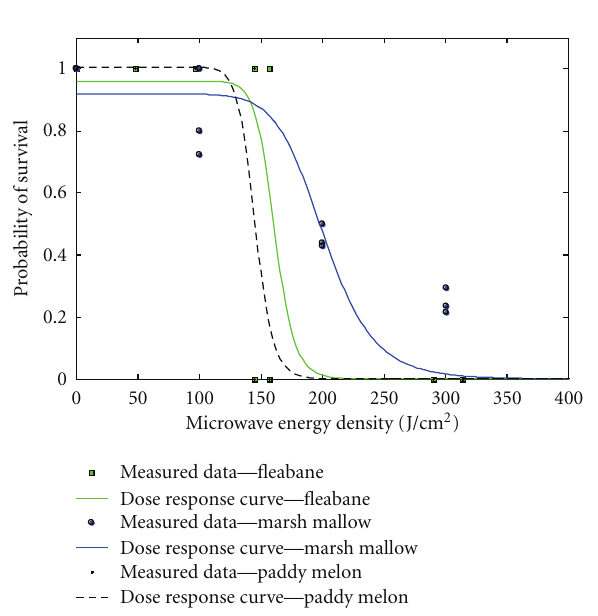
means with di ff erent superscripts are significantly di ff erent to one another.